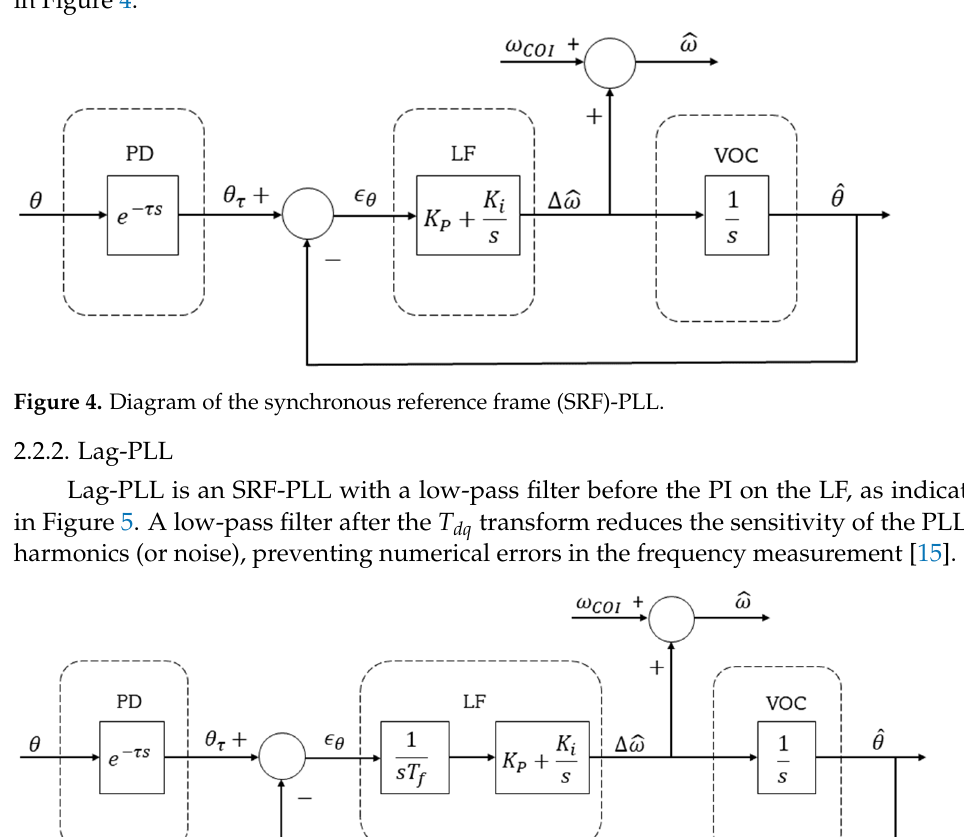
Figure 5. Diagram of the Lag-PLL.